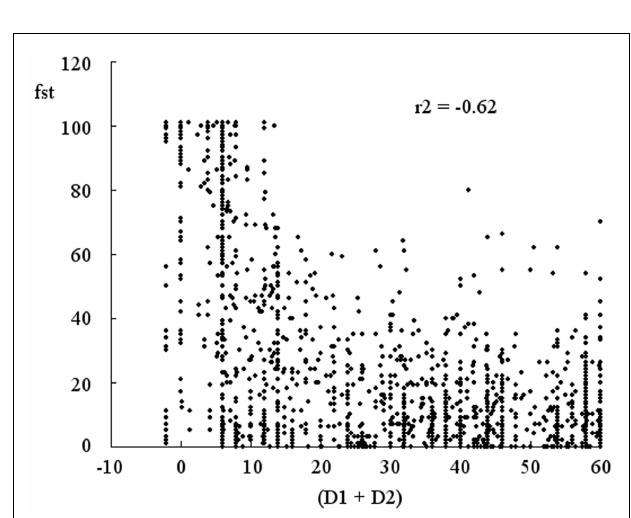
FIGURE 11 | Correlation between the frequency of stimulation and ( D 1 + D 2). The frequency of stimulation, “fst”, increases as the disequilibrium ( D 1 + D 2) decreases.The correlation coefficient of − 0.62 is highly significant.